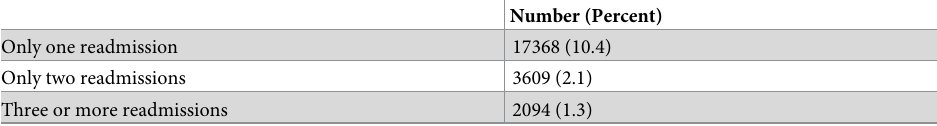
Table 2. Unadjusted number of readmissions.